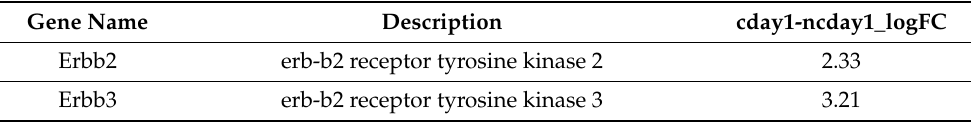
Table 4. Expression of Erbb receptors in chronic wounds.